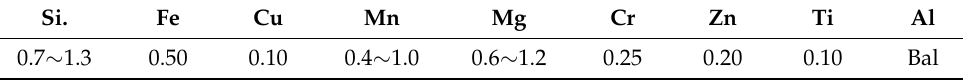
Table 2. Experimental scheme.